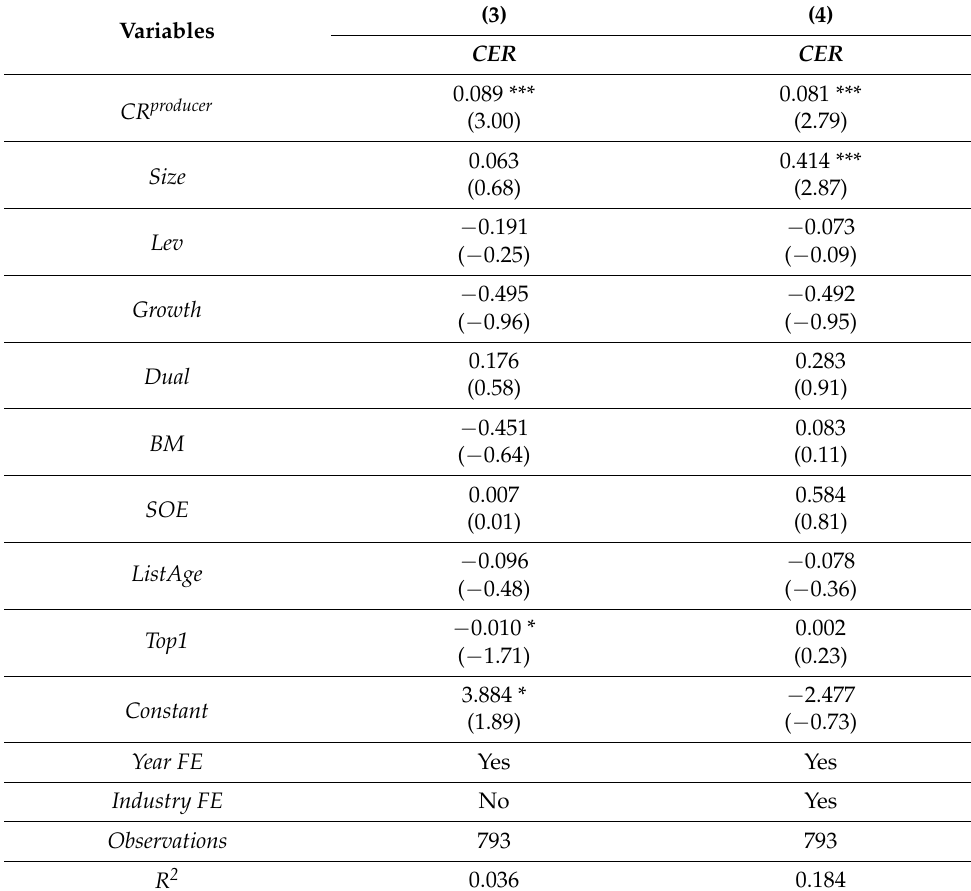
Table 4. Regression of supply chain power on the environmental responsibility of upstream